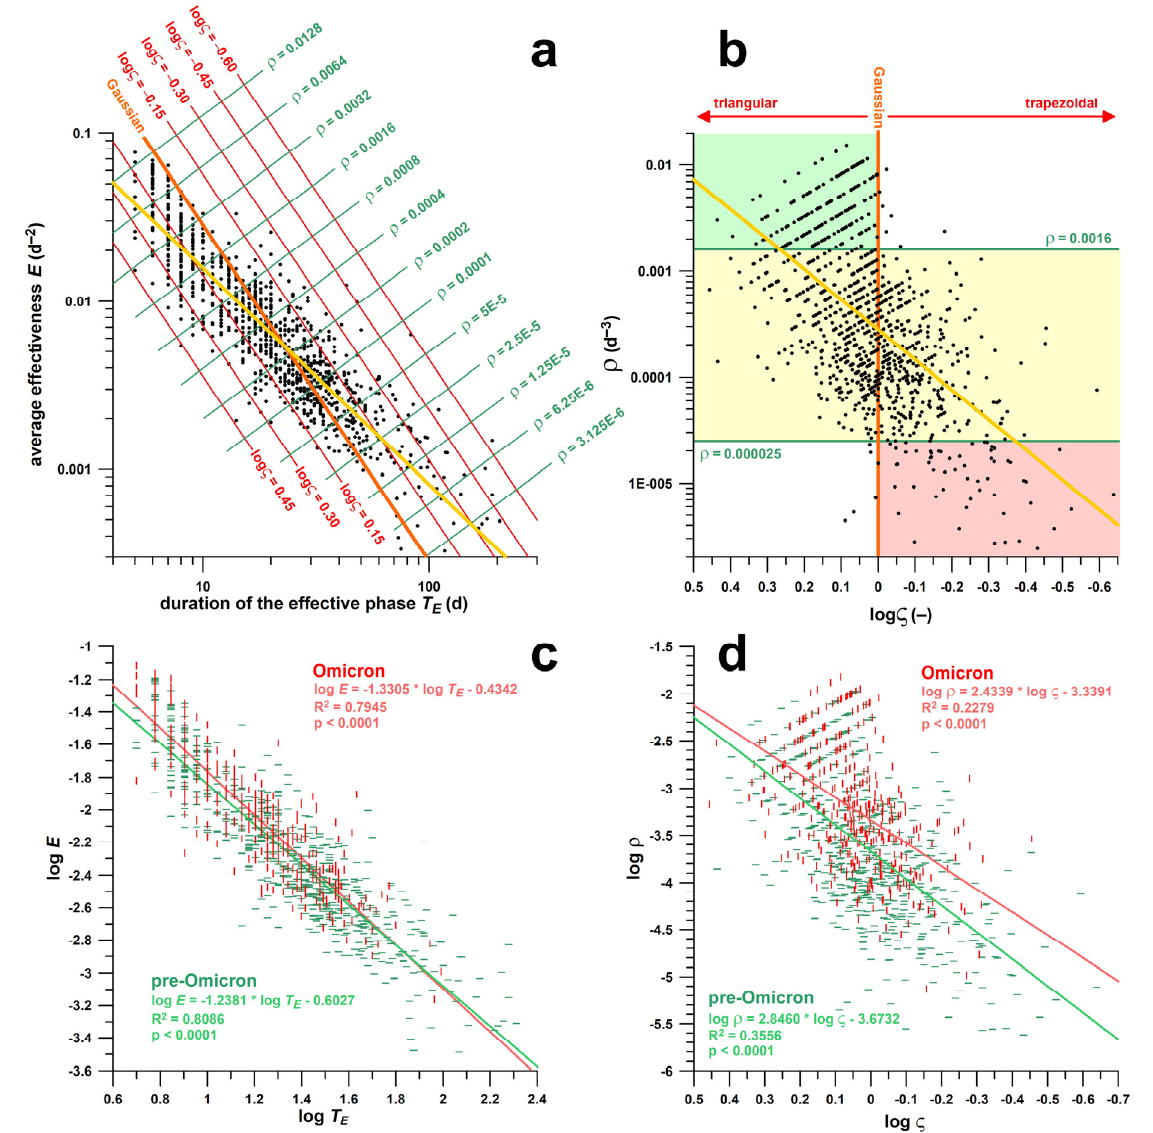
Figure 5. Correlations; ( a ) effectiveness E data of 1000 waves against the duration of the effective phase T E with associated isolines of ρ (= E / T E ) and log ς (wave shape factor); ( b ) ρ against log ς ; ( c ) effectiveness E against the duration of the effective phase T E separately for Omicron and pre-Omicron waves; ( d ) ρ against log ς separately for Omicron and pre-Omicron waves.